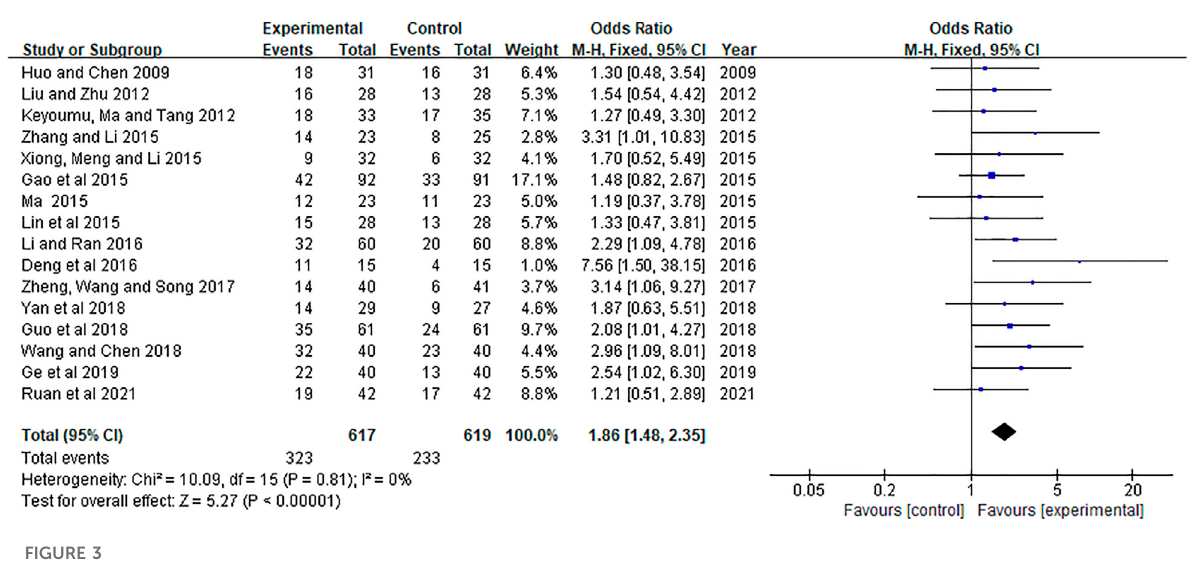
FIGURE 3 Meta-analysis of